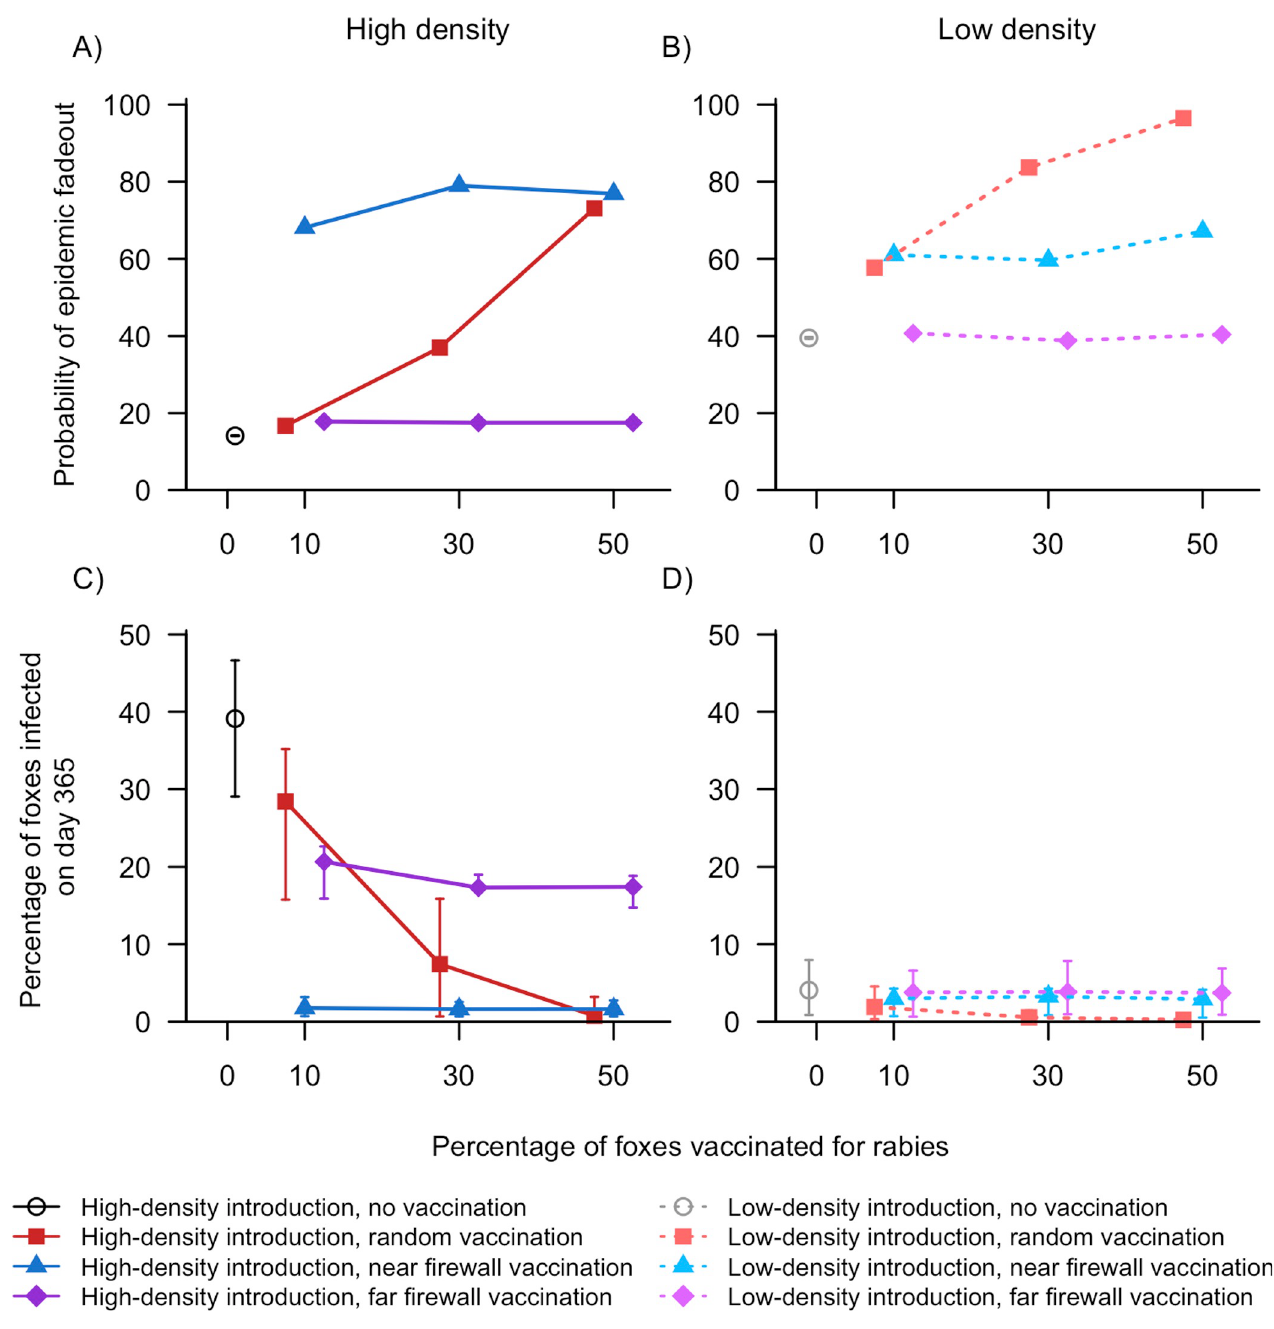
Fig 4. Model simulation results (medians, 25% and 75% quartiles) of rabies introduction to areas of San Clemente Island with high (A, C) or low (B, D) fox density and varying levels of fox vaccination (0%, 10%, 30%, or 50% of the population) distributed randomly or in a firewall. Simulations with firewall vaccination had either 5% of foxes (“near firewall”) or 20% of foxes (“far firewall”) on the side of the firewall where rabies was introduced. As the percentage of vaccinated foxes increased, the probability of epidemic fadeout (A, B) generally increased and the percentage of foxes infected (i.e. latent, infectious, or dead) by the end of the 365-day simulation (C, D) generally decreased. Note differing y-axes between upper and lower